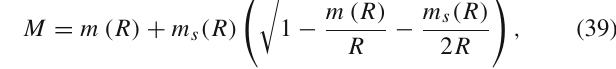
Fig. 4 Variation of the velocity of the sound, η , with the radial coor- dinate r , for tow values of mass M and when the parameter of DE γ is fixed for spherical object PSR J1614-2230